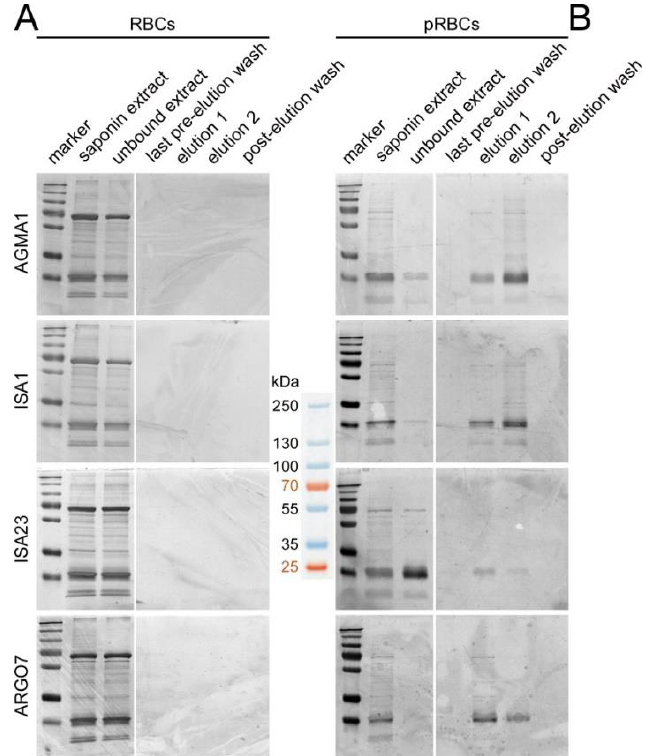
Figure 4. Silver-stained SDS-PAGE of pRBC saponin extracts run through four affinity chromatography columns where AGMA1, ISA1, ISA23 or ARGO7 had been immobilized. ( A ) A RBC extract was first loaded, and after the corresponding washing-elution-washing steps ( B ) a pRBC extract was loaded in the same column. The approximate masses (kDa) of the seven bands from the molecular weight marker are indicated in the space between the